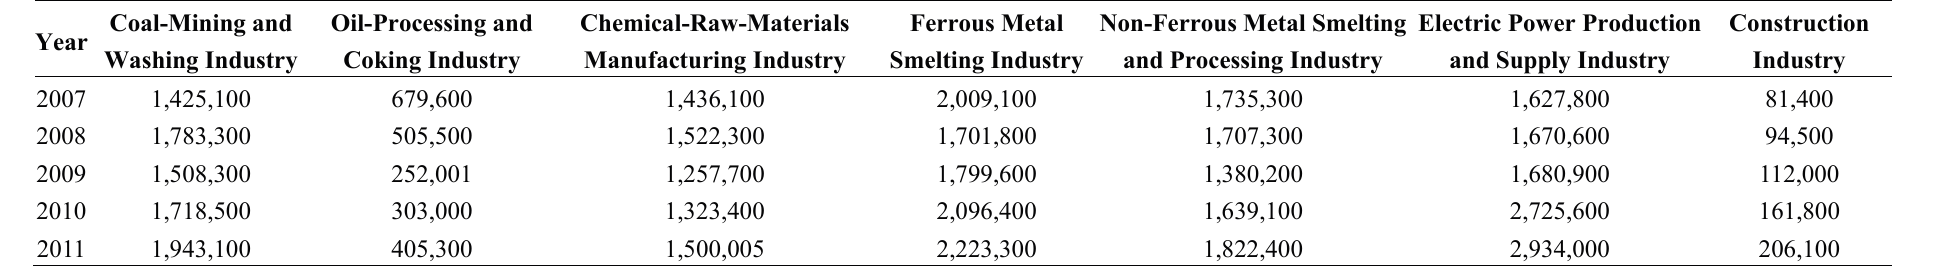
Table 14. The total power used of industries in Shanxi Province from 2007 to 2011 (10 thousand Kwh) [30–34].